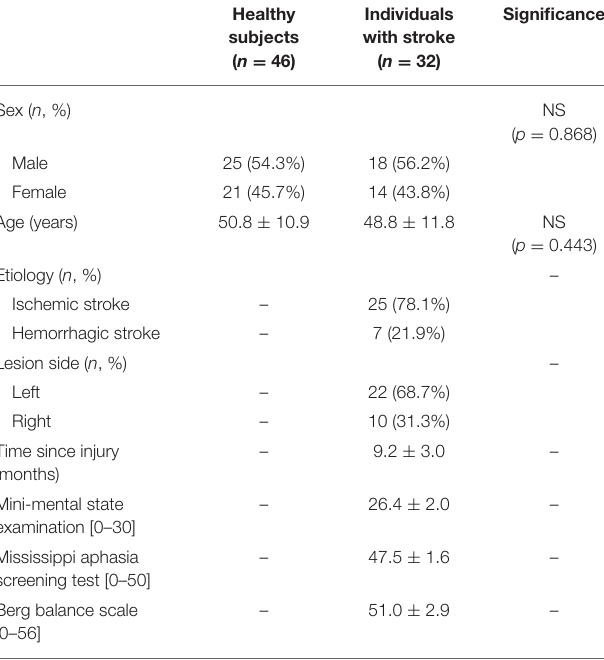
TABLE 1 | Characteristics of the